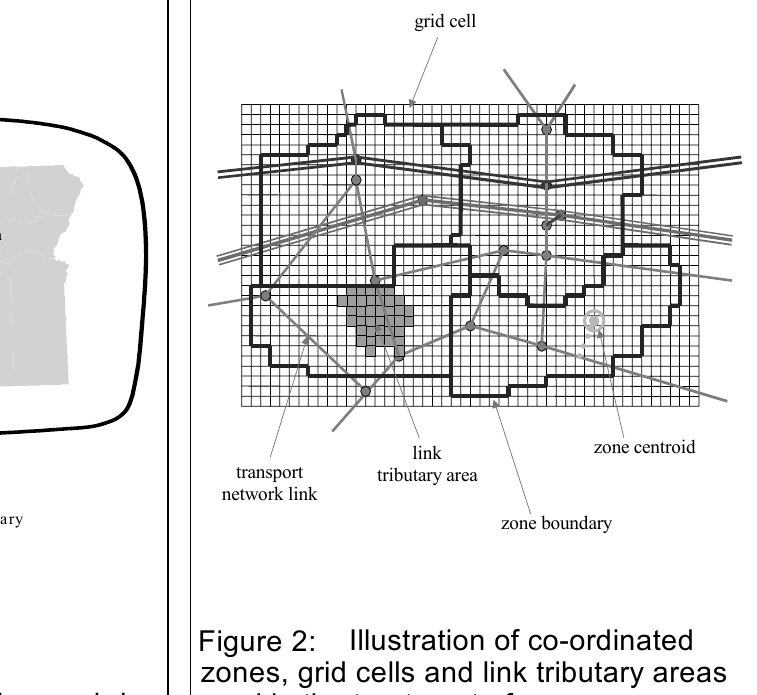
Figure 2: Illustration of co-ordinated zones, grid cells and link tributary areas used in the treatment of space Figure 1: Area covered by